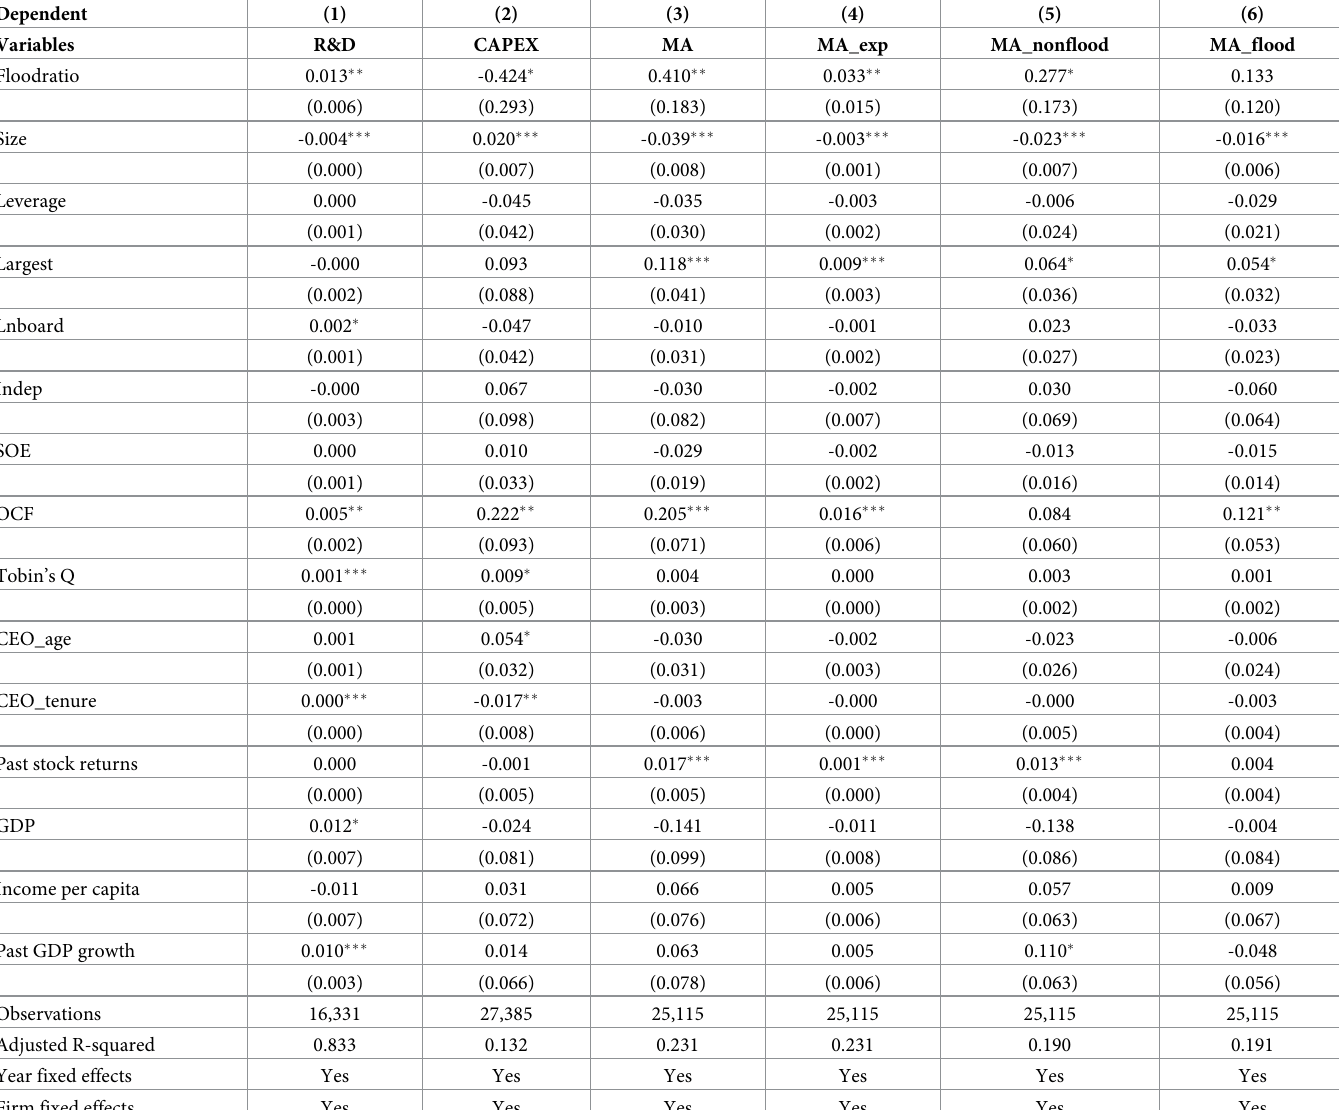
Table 6. Flooding and firm investment policy. This table reports the regression results of the effects of flooding on firm investment policy. Dependent variables are R&D expenditures to total assets ( R&D ) in column 1, capital expenditures to total assets ( CAPEX ) in column 2, probability of conducting M&As ( MA ) in column 3, M&A expenses to total assets ( MA_exp ) in column 4, probability of conducting M&As in non-flooding city ( MA_nonflood ) in column 5, and probability of conducting M&As in flooding city ( MA_flood ) in column 6, respectively. Variable definitions are in Table A1 in the S1 Appendix. Robust standard errors are clustered at the city-year level and reported in parentheses. � , �� and ��� indicate the significance levels at 10%, 5% and 1%,